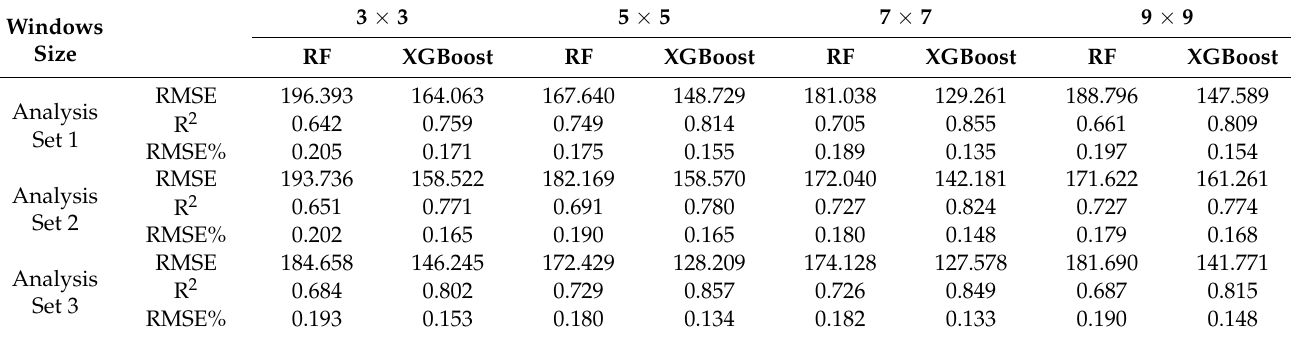
Table 2. The AGB estimation model accuracy of four window sizes for different analysis sets in the training set as demonstrated by R 2 , RMSE, and